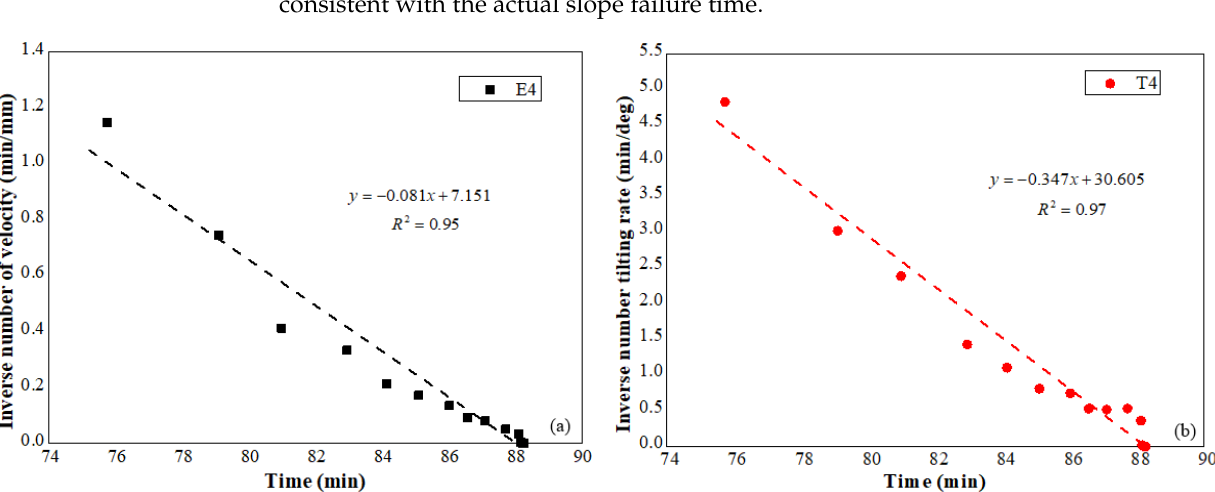
Figure 13. ( a ) Time history of the displacement at subsurface in Field Test 2, ( b ) time series of the tilting angle at the subsurface in Field Test 2.